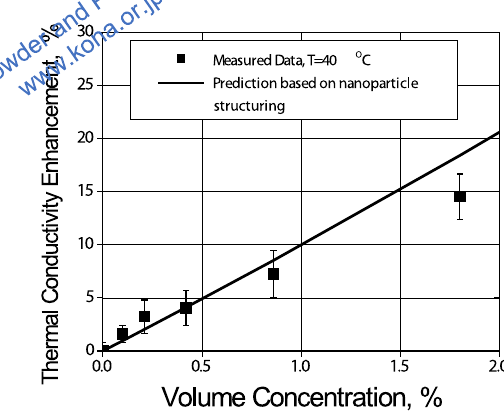
Fig. 6 Effect of nanoparticle concentration on the convective heat transfer under natural convection